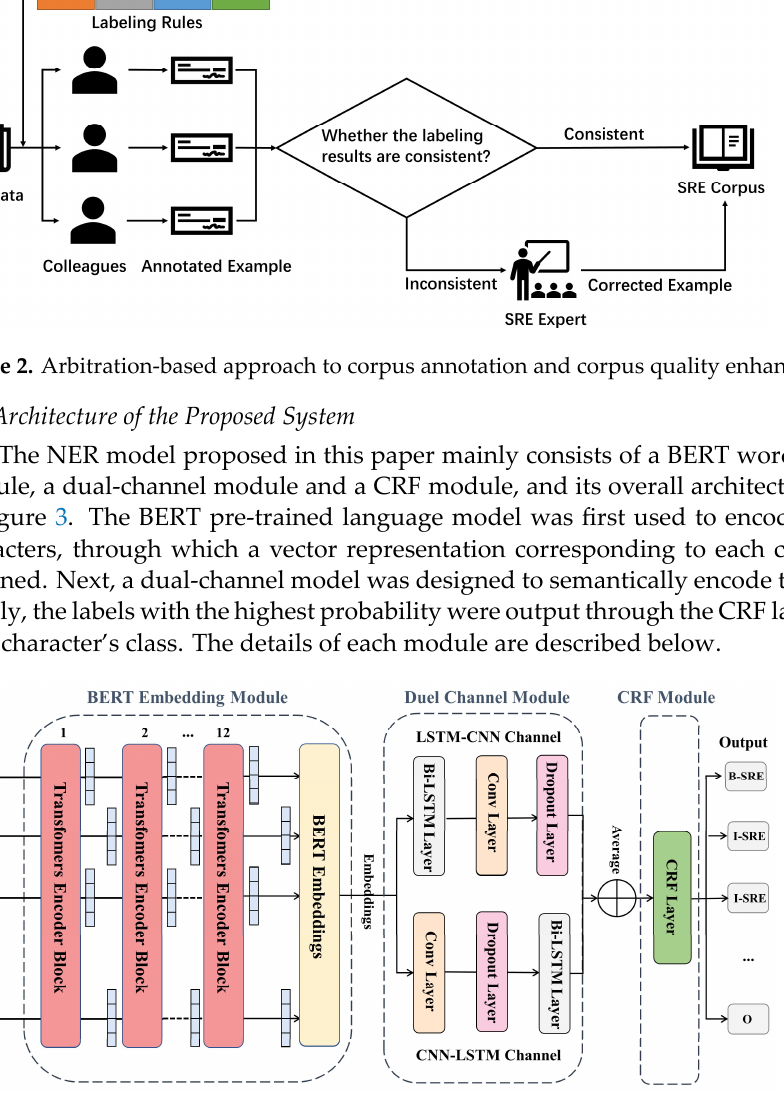
Figure 3. BERT-based dual-channel named entity recognition model. Figure 3. BERT‑based dual‑channel named entity recognition